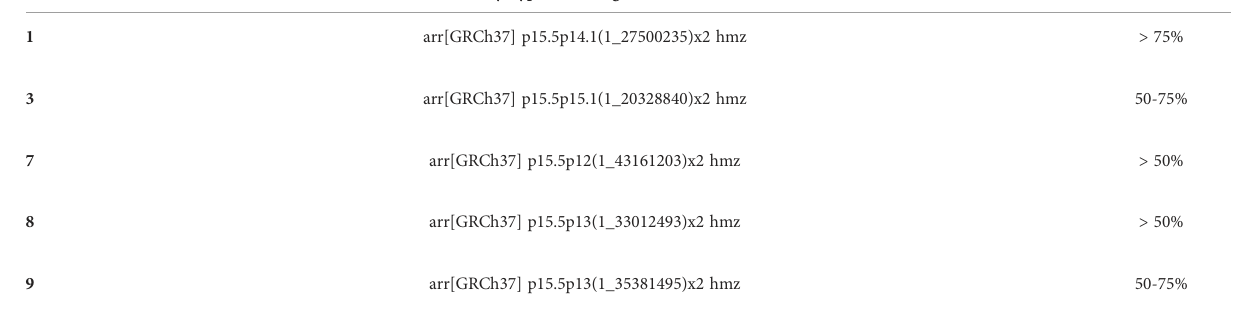
TABLE 2 Molecular microarray